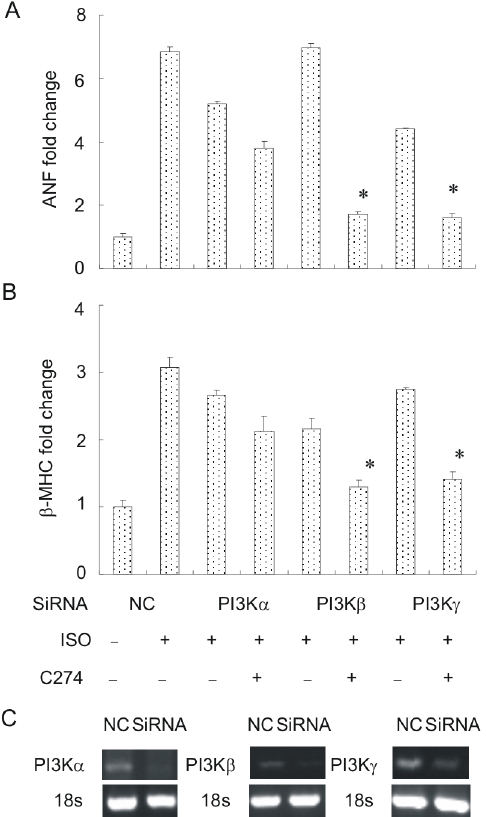
Figure 5. Gene silencing of PI3K a cancels out CpG-ODN’s antihypertrophic effect in NRVMs. (A, B) Effects of gene silencing of different PI3K isoforms on C274’s antihypertrophic efficacy marked by ANF (A) and b -MHC mRNAs (B). Isoproterenol was used to induce PCH, and ANF and b -MHC mRNAs were used as PCH markers quantified by qPCR assays. C274 pretreatment significantly blunted isoproterenol- induced expression of ANF (A) and b -MHC (B) but failed to do so in cells with gene knock-down of PI3K a (A, B). C274 pretreatment still significantly prevented isoproterenol-induced expression of ANF (A) and b -MHC (B) in cells with gene knockdown of PI3K b or PI3K c (A, B). Neonatal myocytes were transfected for 6 h with control or siRNAs specific to PI3K a , PI3K b or PI3K c . 36 h later, cells were incubated with C274 (5 m g/ml 6 12 h) followed by isoproterenol (10 m M 6 48 h). (* p , 0.05 versus isoproterenol group). (C) RT-PCR assays showing